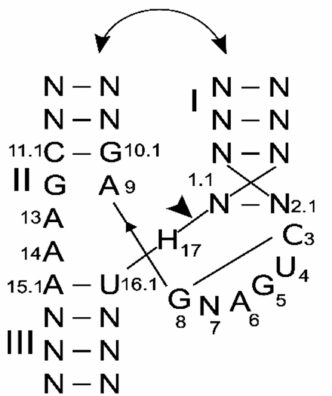
Figure 1. The structure and sequence consensus of hammerhead ribozymes (HHRz). The standard numbering of positions in the catalytic core of HHRz is shown. The cleavage site is indicated by an arrow. H: stands for all the nucleotides except G. The curved arrows illustrate the tertiary interaction between the stems I and